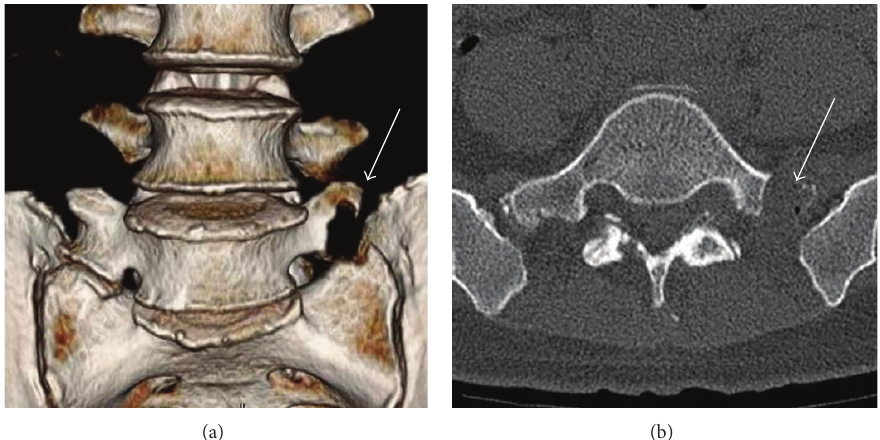
Figure 5: Postoperative three-dimensional reconstructed image (a) and axial image (b) showing successful resection of the articulation